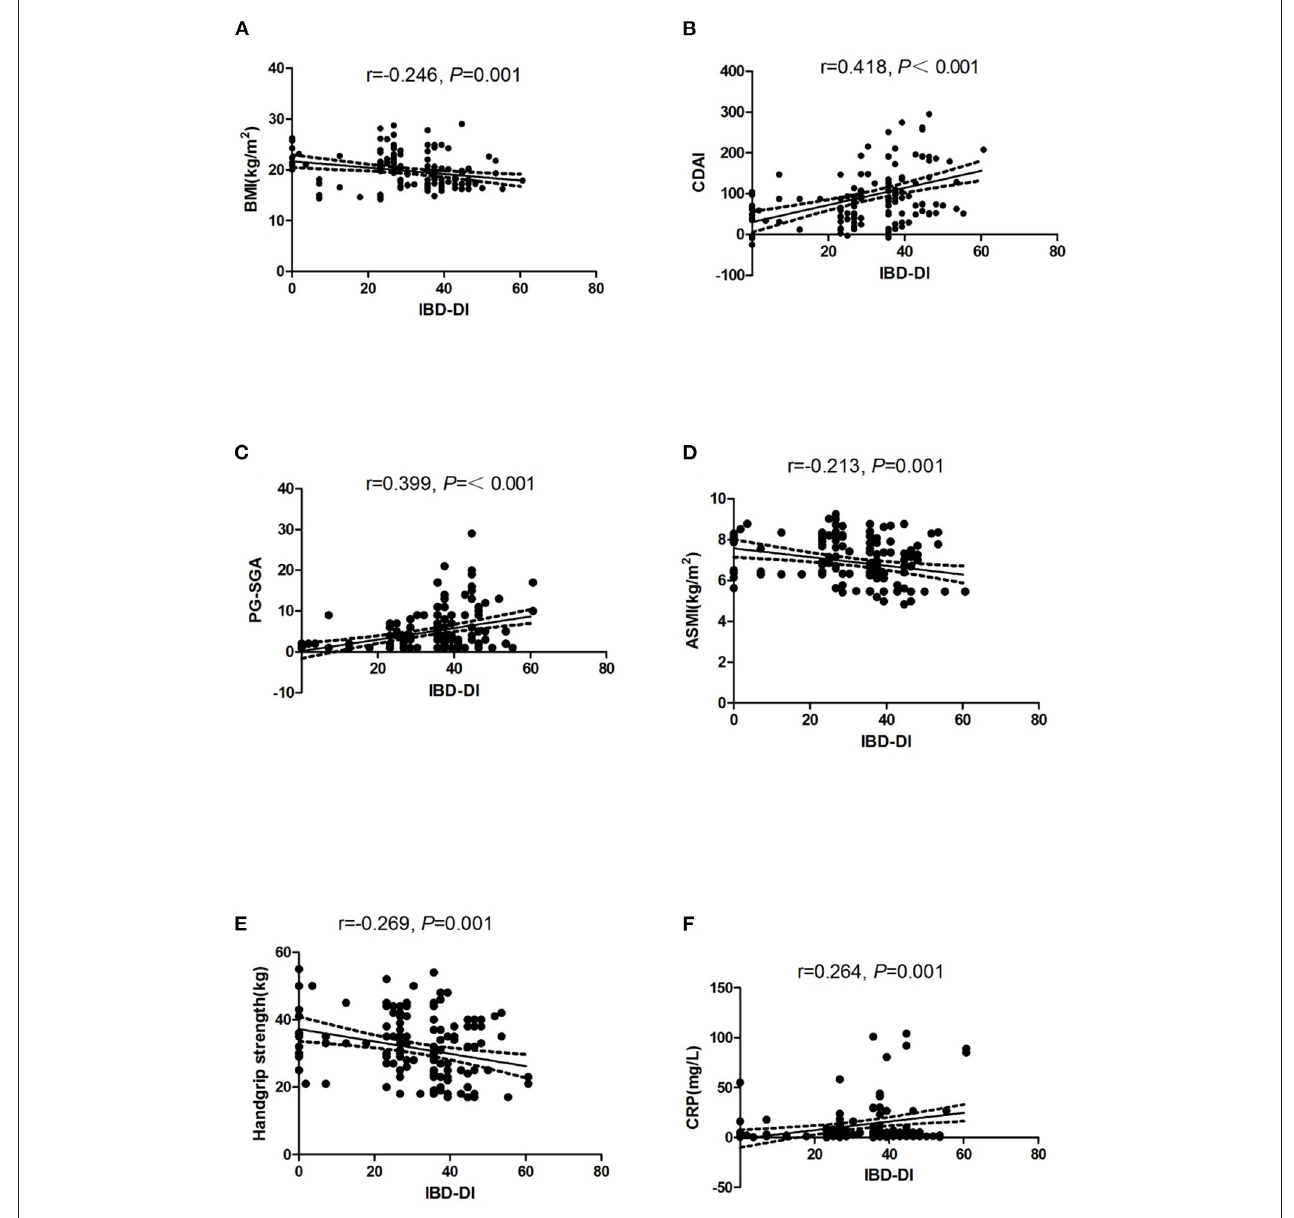
FIGURE 2 | Dispersion graphs depicting correlations between IBD-DI and BMI (A) , CDAI (B) , PG-SGA (C) , ASMI (D) , Handgrip strength (E) , and CRP (F) . P -values on each graph were calculated for all CD patients. r indicates the Spearman’s rank correlation coefficient. IBD-DI, inflammatory bowel disease disability index; BMI, body mass index; CDAI, Crohn’s disease activity index; PG-SGA, Patient-Generated Subjective Global Assessment; ASMI, appendicular skeletal muscle mass index; CRP, C-reactive